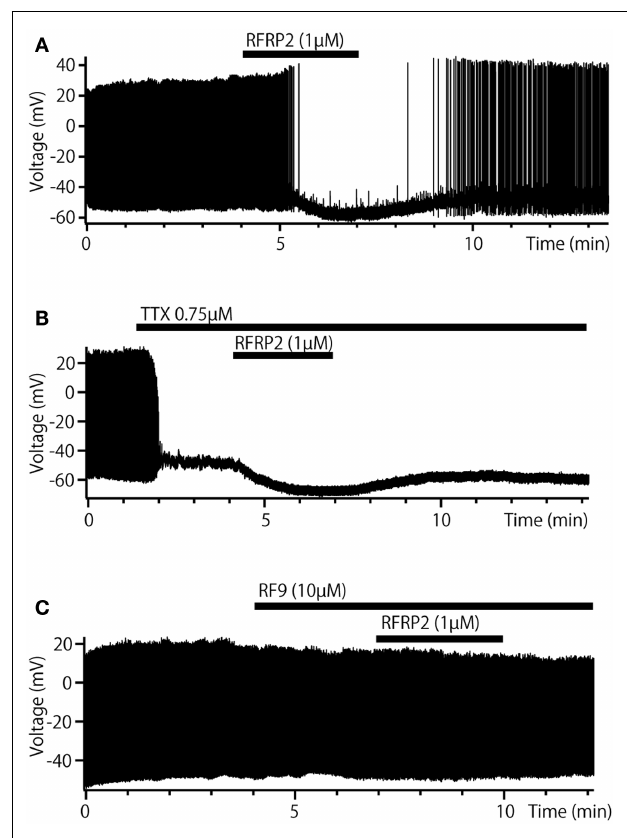
FIGURE 6 | Inhibitory synaptic regulation by RFRP ofTN-GnRH3 neurons in dwarf gourami . (A) Bath-applied RFRP2 reversibly decreases the frequency of pacemaker activity. (B) In the presence ofTTX, RFRP2 hyperpolarizes the cell. (C) In the presence of RF9 (a potent antagonist of GPR147/74, candidate NPFF, and RFRP receptors) the inhibitory effect of RFRP2 is